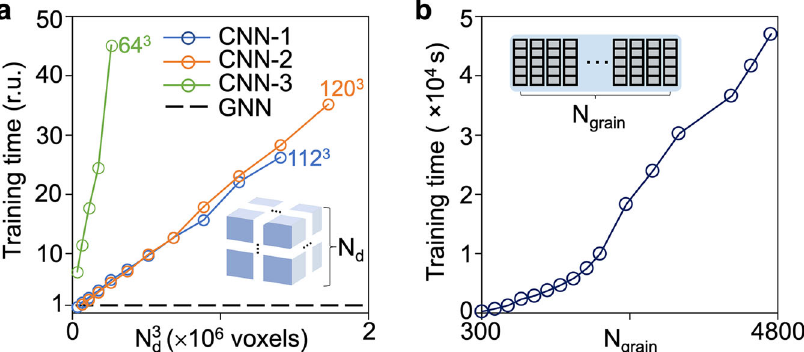
Fig. 5 Computational ef fi ciency of the GNN model. a The training time (the data loading time plus model training time) of our GNN model and the three baseline CNN models as a function of the number of voxels in the 3D polycrystalline microstructure, denoted as N d3 , with N d varying from 32 to 128. The number of grains in each microstructure image, denoted as N grain , is fi xed to be 300. The training time is shown in the reduced unit (r.u.), using the training time of the GNN model as the reference (training time = 1). b The training time of our GNN model as a function of N grain in the range of 300 to 4700. The number of features in each grain/node is fi xed to be 5. The training time is shown in real unit